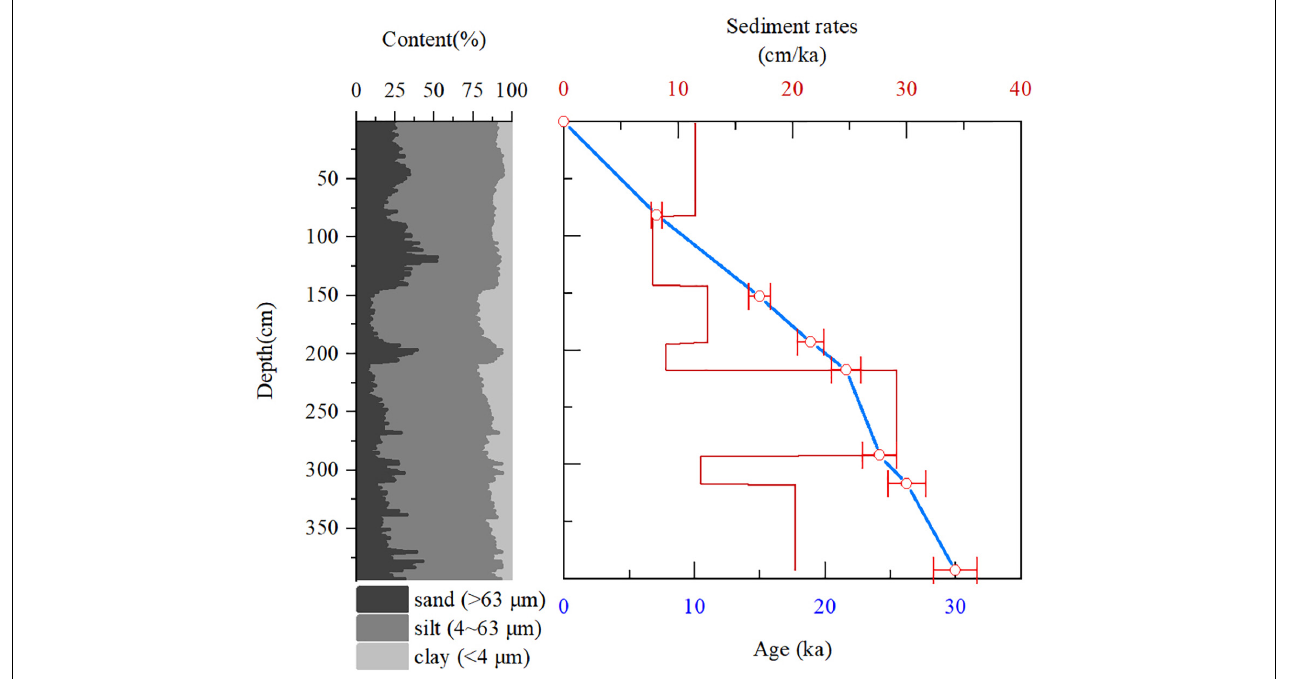
FIGURE 2 | Lithologic column profile and calendar age of LV53-18-2. The 7 OSL date samples are shown with an uncertainty of 2 σ